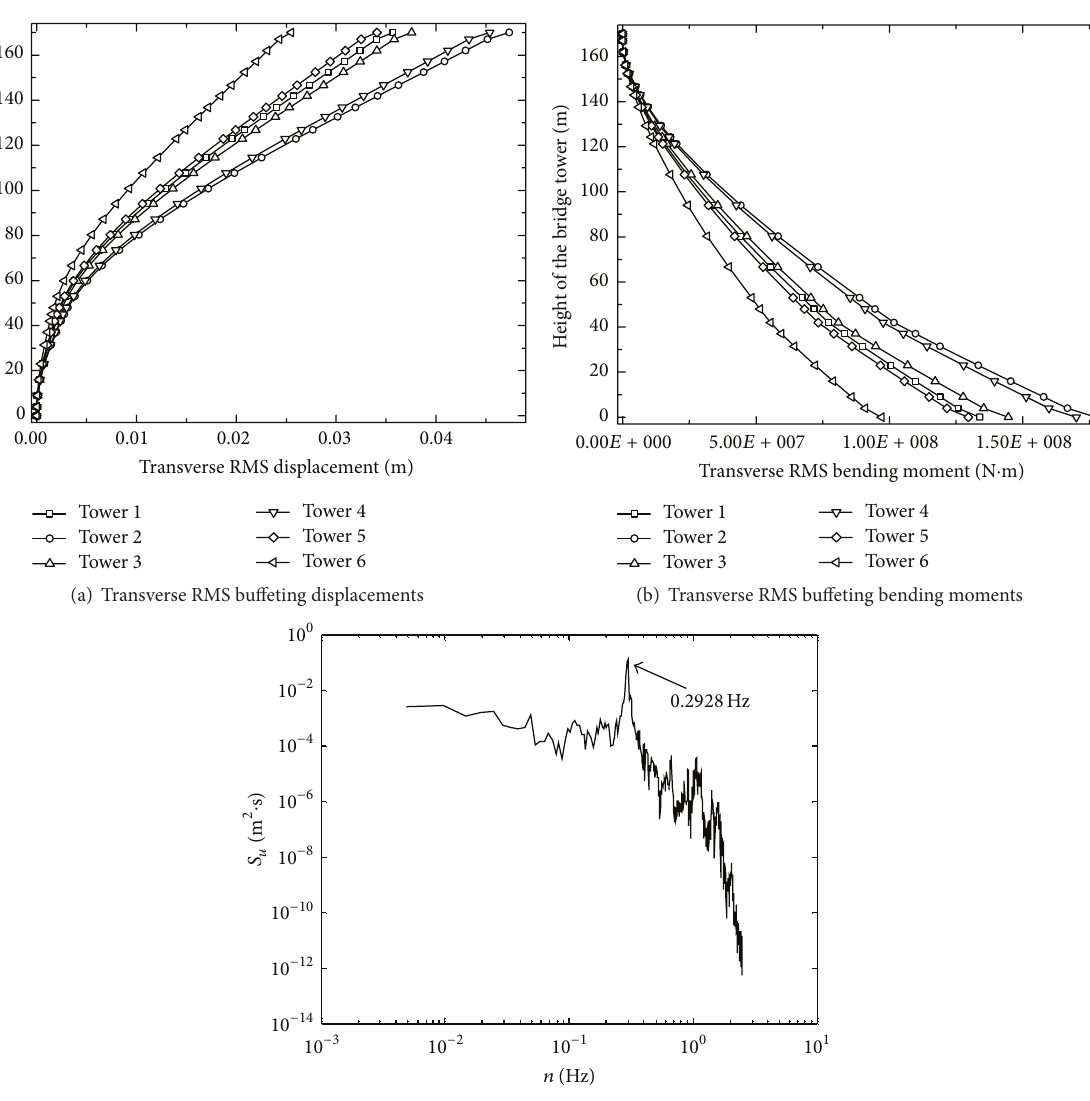
Figure 14: Transverse buffeting responses of bridge